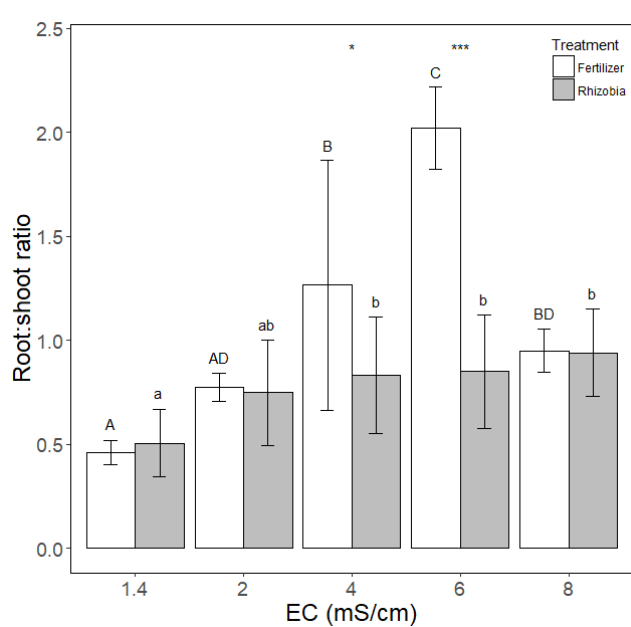
Fig. 4: Root:shoot ratio for plants with and without rhizobia. Bars are means, stars represent statistical difference based on t-test within sa- linity treatment group (significance: * p<0.05, *** p<0.001). Lower (rhizobia) and uppercase letters (fertilizer, no rhizobia) show signifi- cant differences among experimental plants according to post-hoc analysis (Tukey’s HSD, p<0.01) after one-way